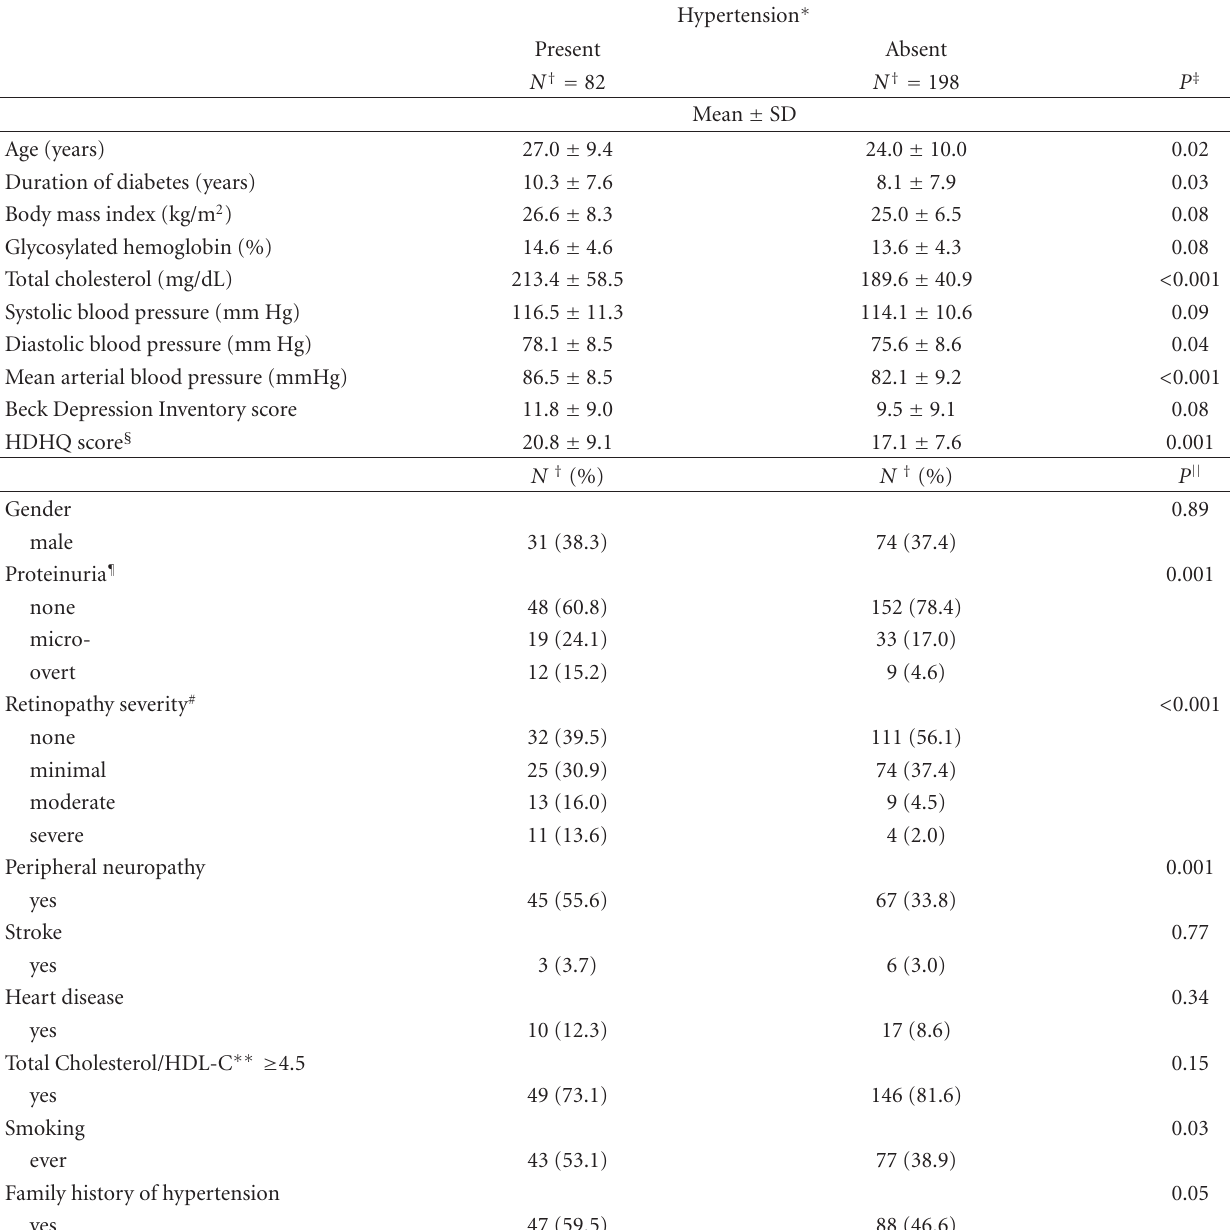
Table 1: Baseline characteristics of patients with and without hypertension ∗ at the six-year